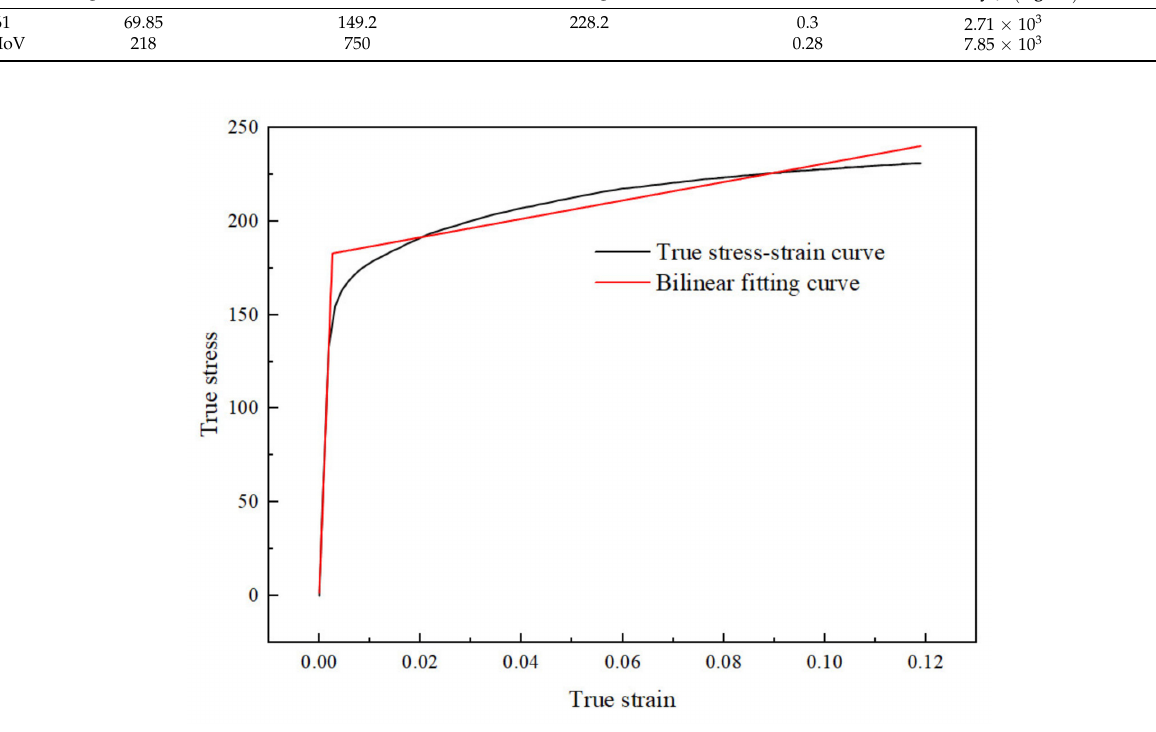
Figure 7. Stress–strain